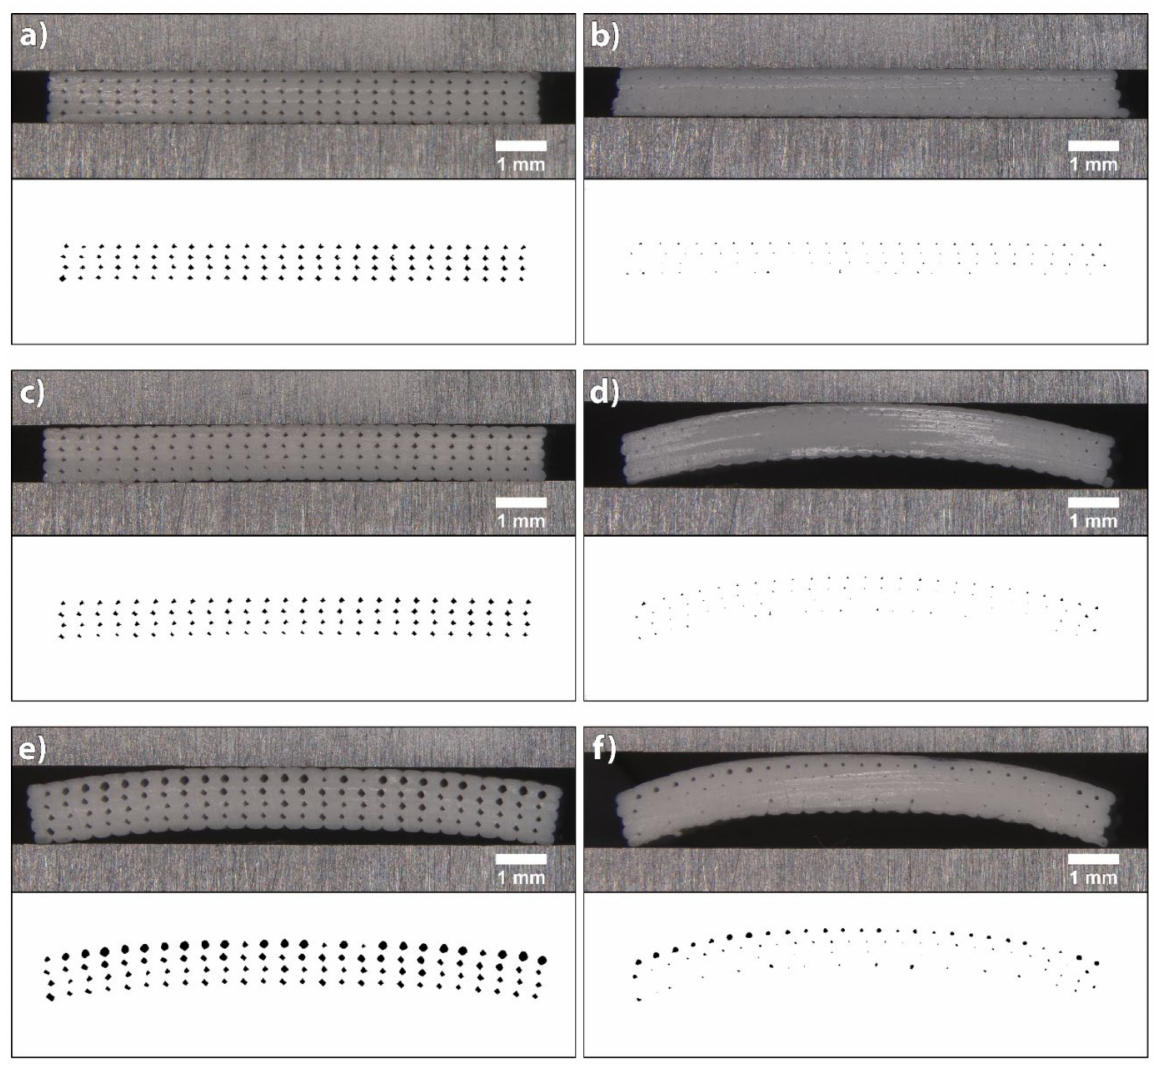
Figure 14. Cross-sectional areas and associated binary images of 3D printed test samples: ( a ) op- timised printing conditions, ( b ) non-optimised printing conditions, ( c ) optimised printing and transformed at 70 ◦ C, ( d ) non-optimised printing and transformed at 70 ◦ C, ( e ) optimised printing and transformed at 90 ◦ C, ( f ) non-optimised printing and transformed at 90 ◦